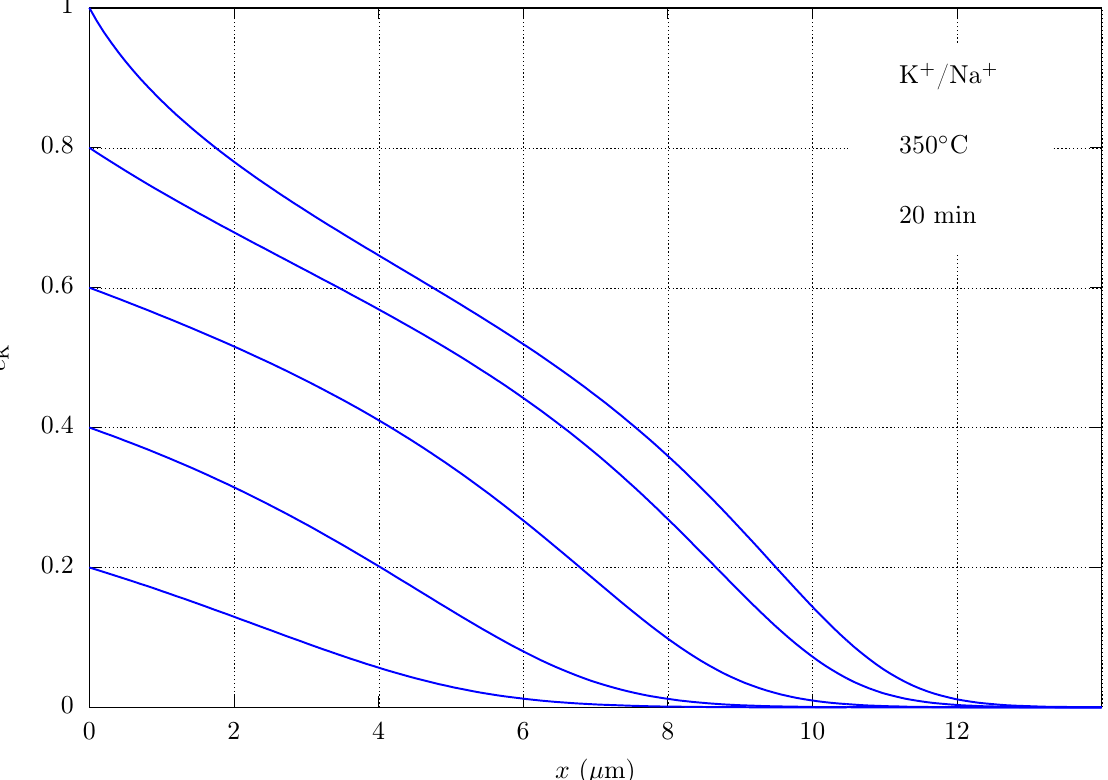
Figure 2. Simulation of molar fraction profiles as a function of depth for a thermal IE by taking into account the MIE. Equation (31) was solved for J 0 = 0 and the boundary conditions c K | ¯ D ( c K ) of Figure 1b was